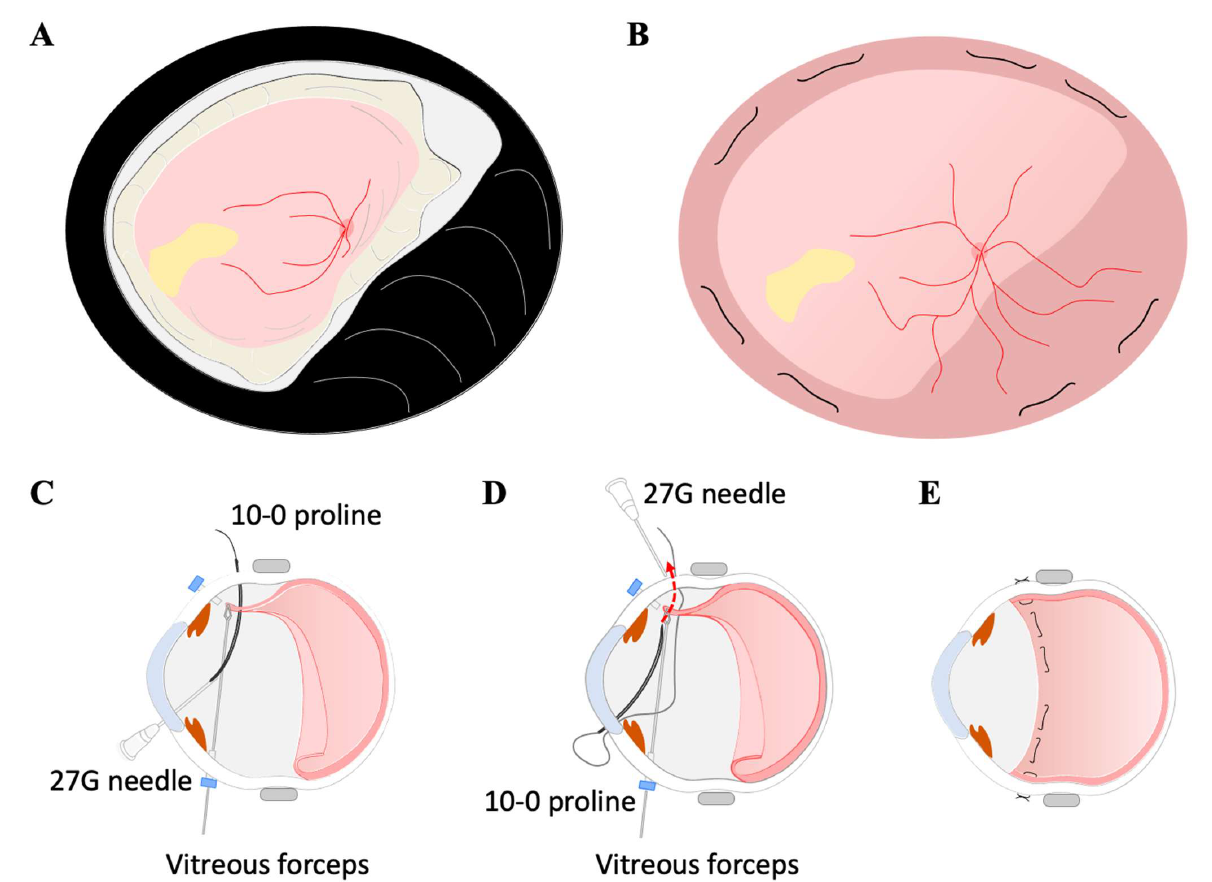
Figure 3. Surgical procedures of the mattress suturing technique using a 10-0 proline long needle. Fundus schema before ( A ) and after the repair of the choroidal avulsion ( B ). A 10-0 proline needle was inserted into the vitreous cavity and passed through the avulsed choroid by grasping the avulsed choroidal edge with vitreous forceps ( C ). A 27G needle was inserted through the corneal side port to access the vitreous body, and the proline needle was inserted into the 27G needle intravitreously. After the proline needle was withdrawn from the 27G needle, the 10-0 proline was inserted through the same corneal side port, and the 27G needle was inserted into the vitreous cavity through the sclera ( D ). The 27G needle was passed through the avulsed choroid by grasping the avulsed choroidal edge with vitreous forceps. The same procedure was performed at two locations in each quadrant ( E ).